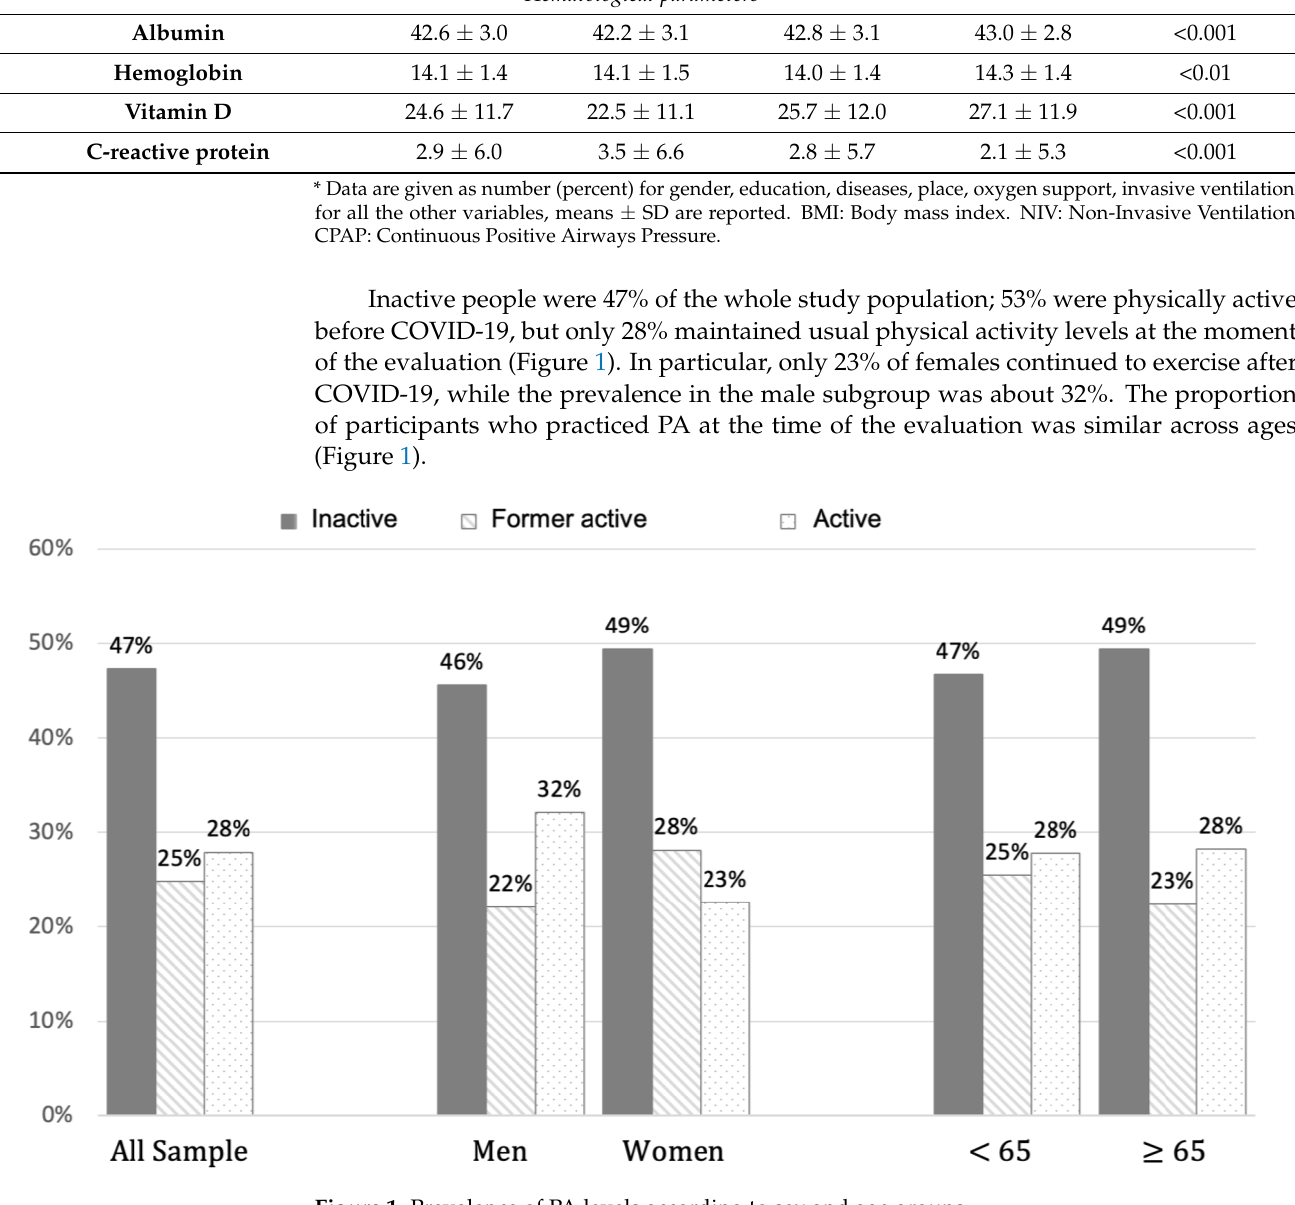
Figure 1. Prevalence of PA levels according to sex and age groups. The average number of days from COVID-19 diagnosis to admission to the outpatient service were similar between inactive and active subjects (85.2 ± 42.7 versus 91.3 ± 34.8, respectively; p = 0.1). COVID-19 severity had the same distribution in the three of the evaluation was associated with a longer distance covered during the 6MWT, greater numbers of repetitions at the 1MSTST, and higher values at the handgrip strength. Active